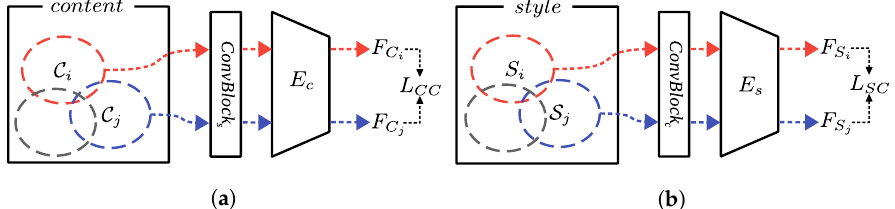
Figure 3. Concept of feature consistency loss: ( a ) Content reference, images with the same character in different font styles; ( b ) Style reference, images with different characters in the same font style. Different colors dotted circles mean sets that have the same content (or style) but different style (or